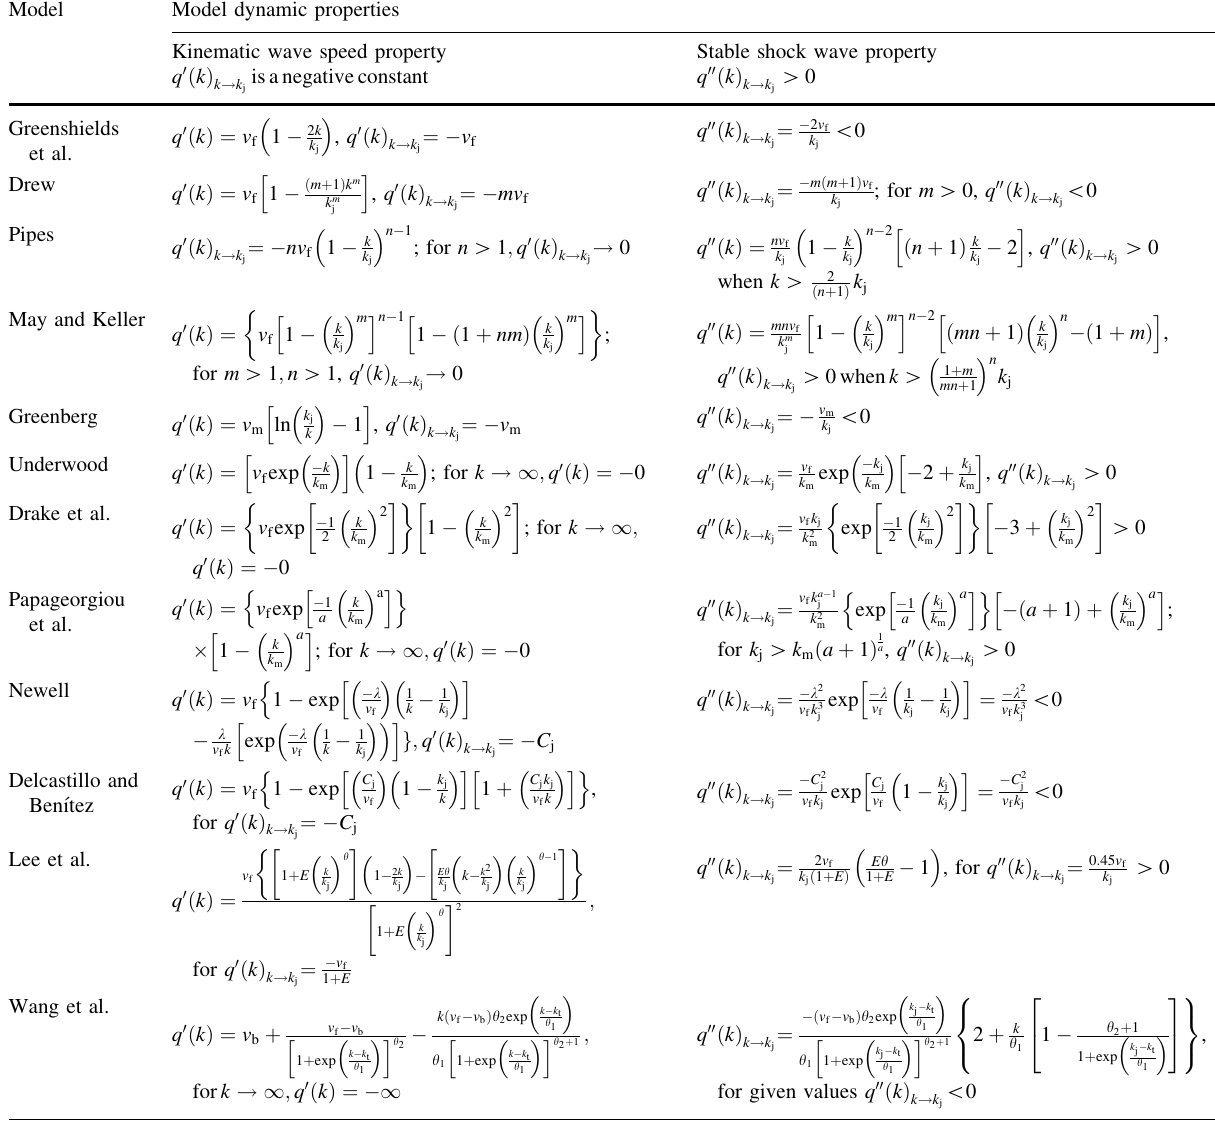
Table 6 Validation of dynamic properties Model Model dynamic